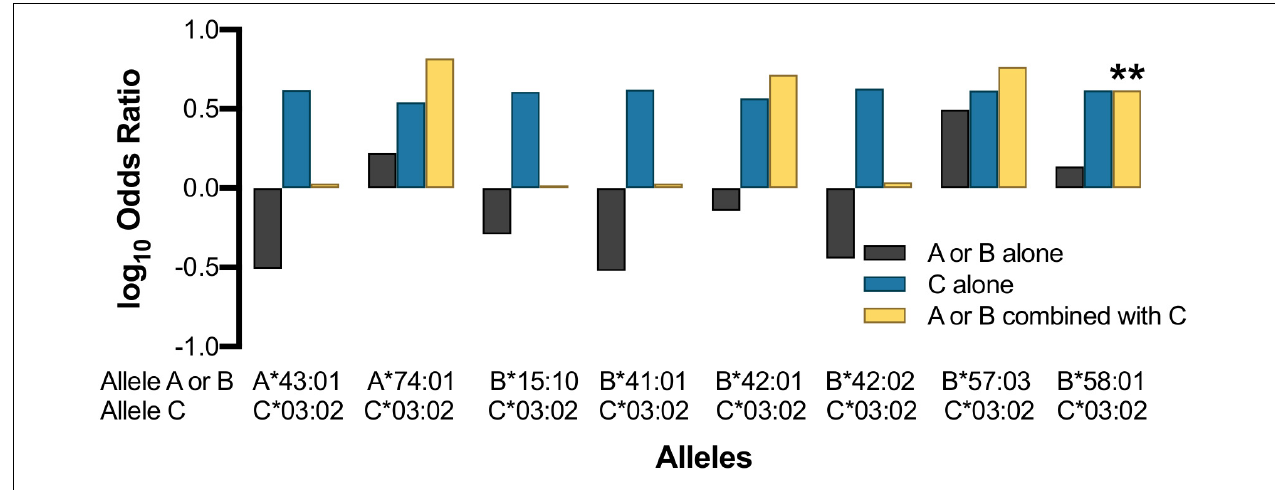
FIGURE 6 | Effect of HLA-C*03:02 on other HLA class I alleles. Asterisk indicates allele combination that is statistically significant ( Pc < 0.05) after correcting by a factor of 9 (Svejgaard and Ryder, 1994).